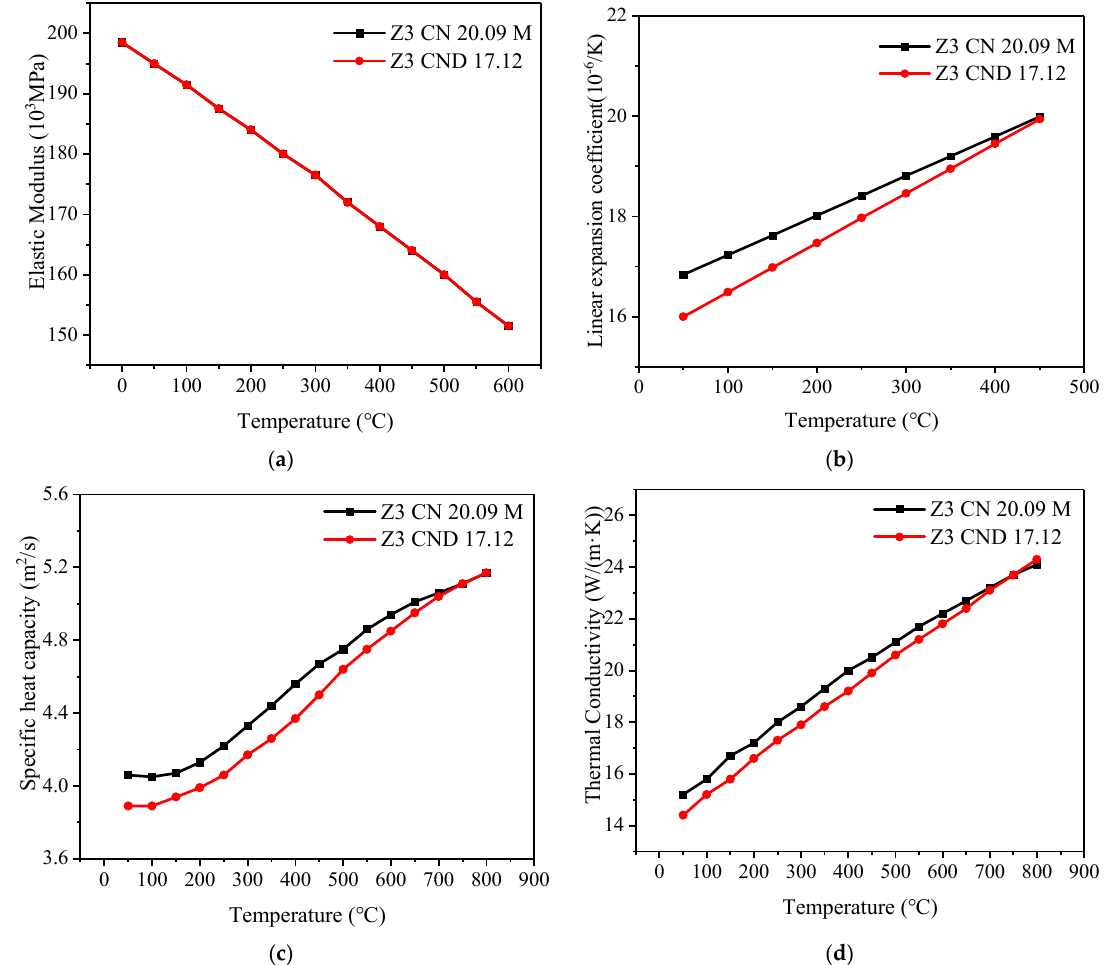
Figure 7. Material parameters at different temperatures. ( a ) Elastic modulus. ( b ) Linear expansion coefficient. ( c ) Thermal conductivity, ( d ) Specific heat capacity.